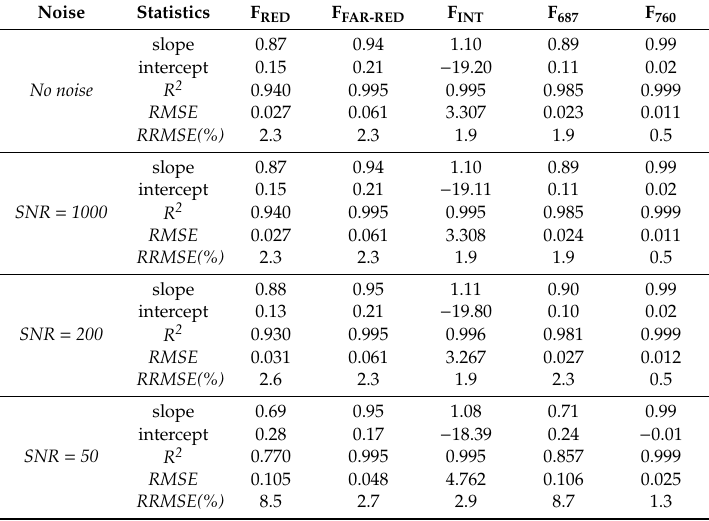
Table 2. Statistical metrics in terms of slope, intercept, coe ffi cient of determination (R 2 ), Root Mean Square Error (RMSE), Relative Root Mean Square Error (RRMSE) of the linear regression model between reference and retrieved values considering di ff erent noise